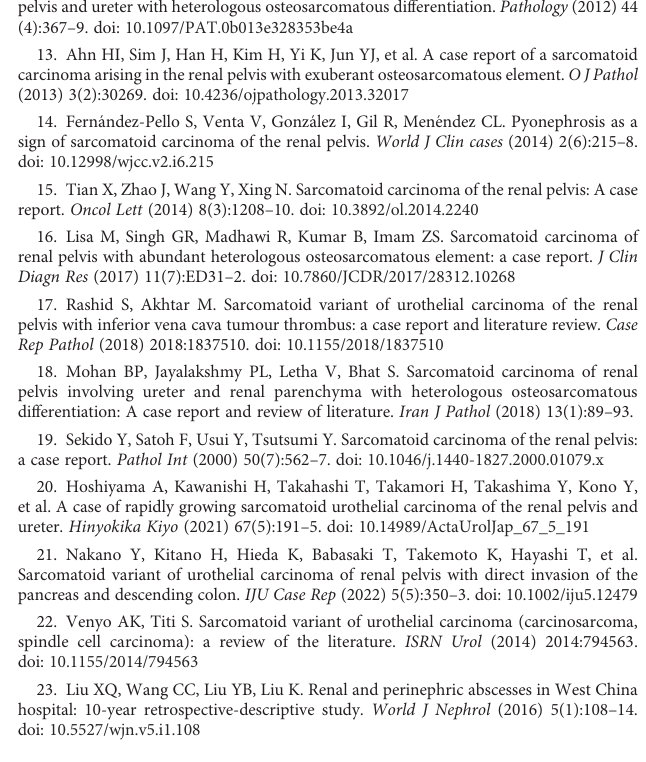
SUPPLEMENTARY FIGURE 1 Enhanced MRI examination. (A) , E : axial DWI; (B) , F : axial ADC imaging; (C) : axial T1-weighted arterial phase imaging; C : axial T2-weighted imaging. SUPPLEMENTARY FIGURE 2 Review of enhanced CT after nephrostomy. (A) : excretory phase; (B) : arterial phase; (C) : venous